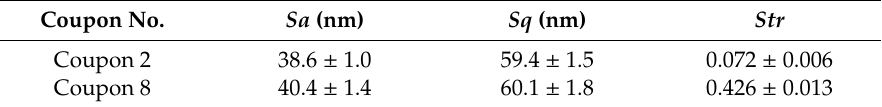
Figure 12. Polishing marks on ( a ) Coupon 2; ( b ) Coupon 8. Table 1. Measured surface roughness parameters of Coupon 2 and Coupon 8.